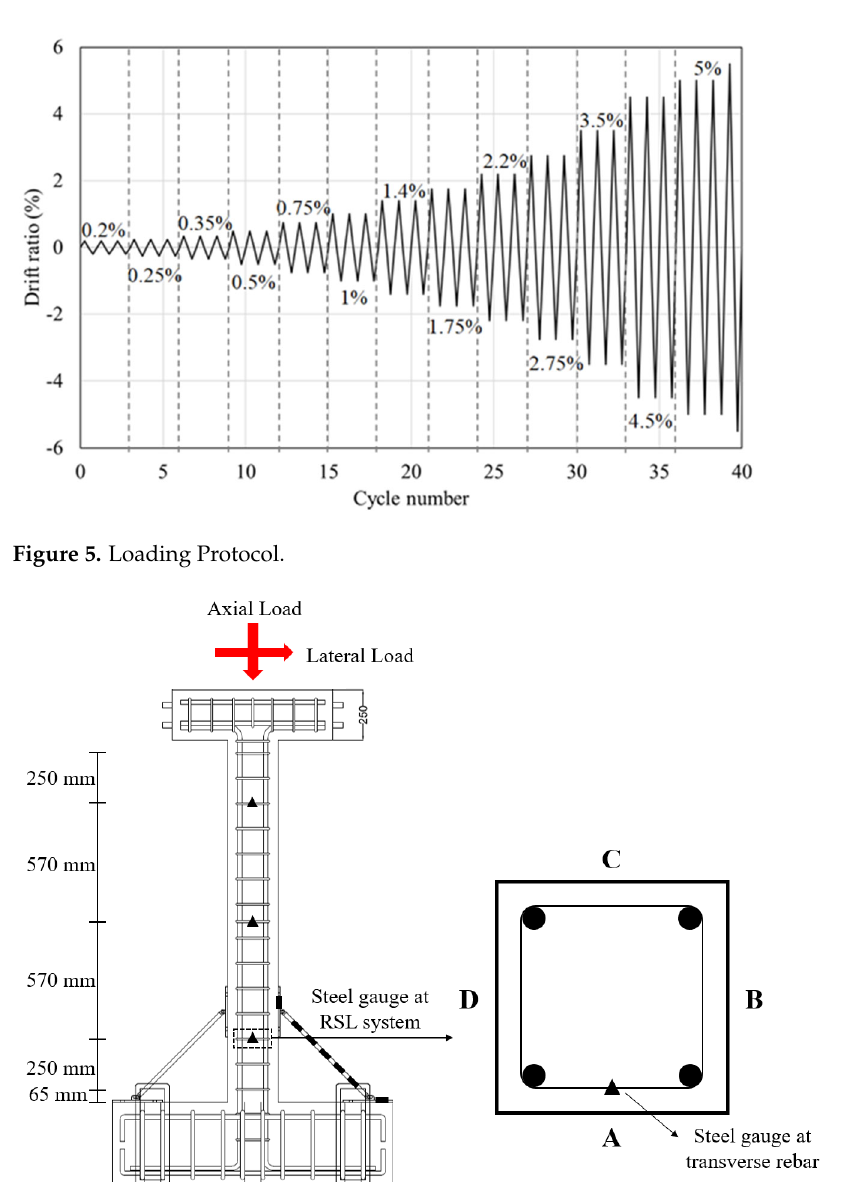
Figure 6. Locations of strain